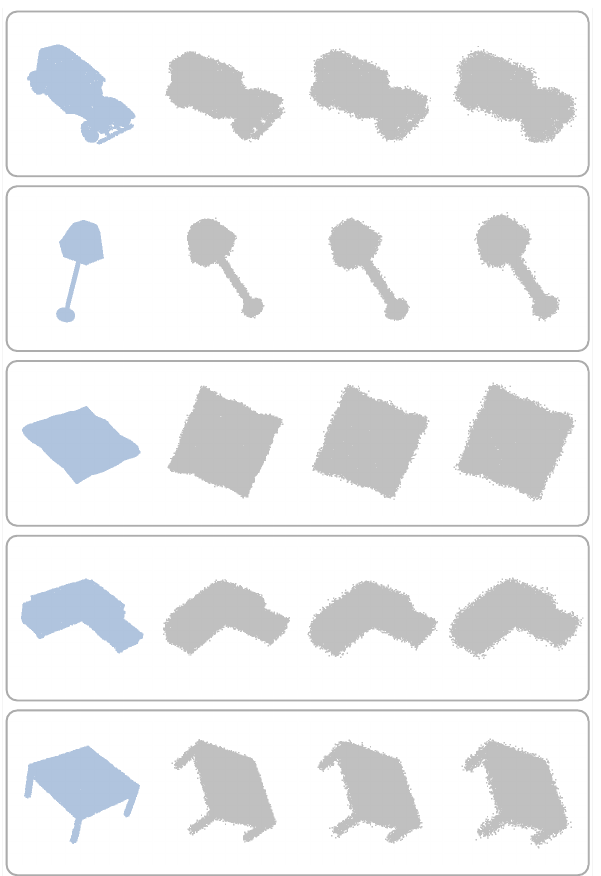
Figure 4. Samples from CMD-Net Dataset: ( left-most column ) noise-free 3D point clouds in the canonical space; rotated instances ( 2nd column ) with σ = 0.01; ( 3rd column ) with σ = 0.015; ( right-most column ) with σ =